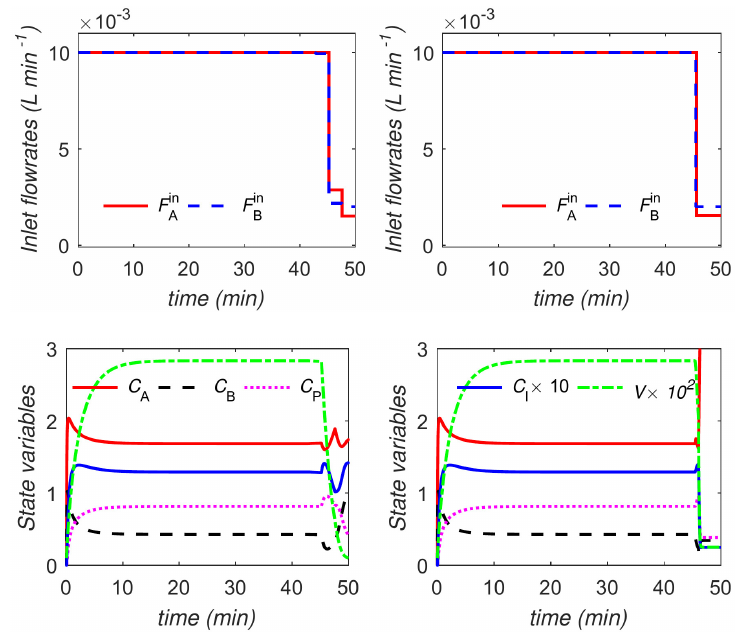
Figure 12. Optimal trajectories for Problem (44) in the case of the uniform discretization with N = 21 ( left ) and the nonuniform discretization with N = 3 ( right )